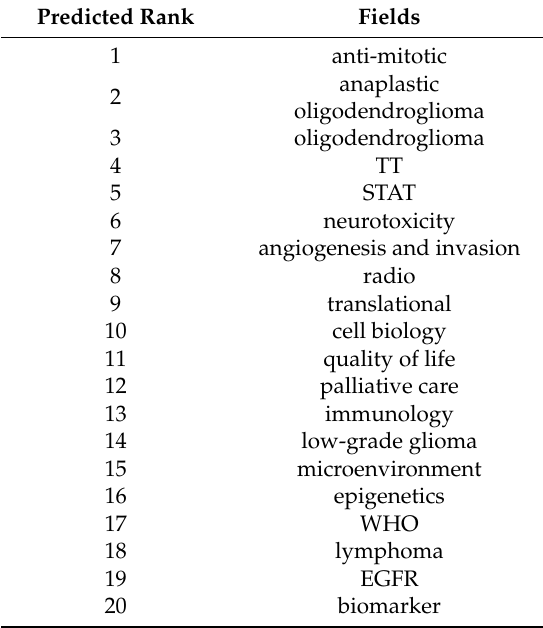
Table 3. Top 20 hottest fields of neuro-oncology in 2019. Predicted Rank